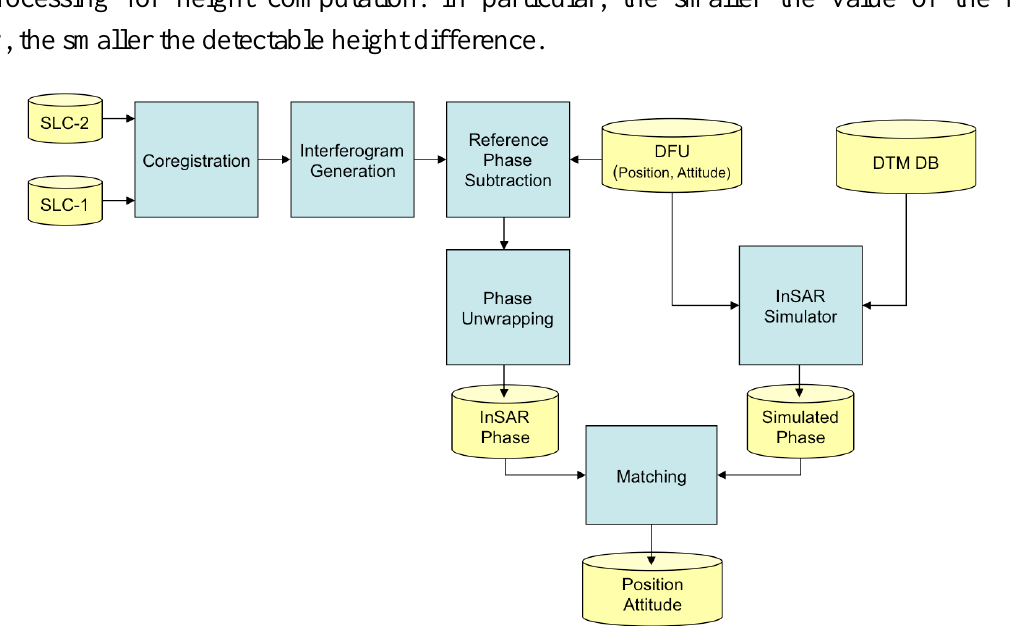
Figure 9. Flow chart of the InSAR based navigation system.